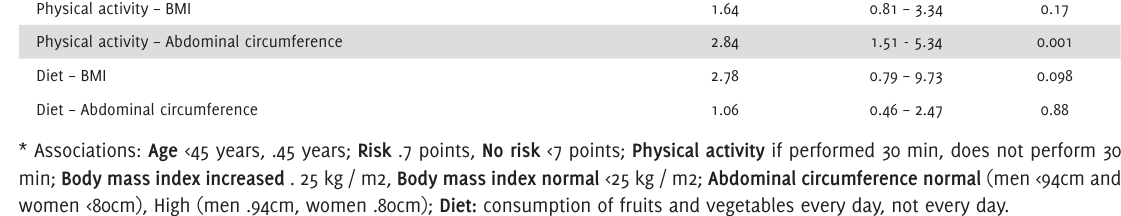
* Associations: Age <45 years, ≥45 years; Risk ≥7 points, No risk <7 points; Physical activity if performed 30 min, does not perform 30 min; Body mass index increased ≥ 25 kg / m2, Body mass index normal <25 kg / m2; Abdominal circumference normal (men <94cm and women <80cm), High (men ≥94cm, women ≥80cm); Diet: consumption of fruits and vegetables every day, not every day.